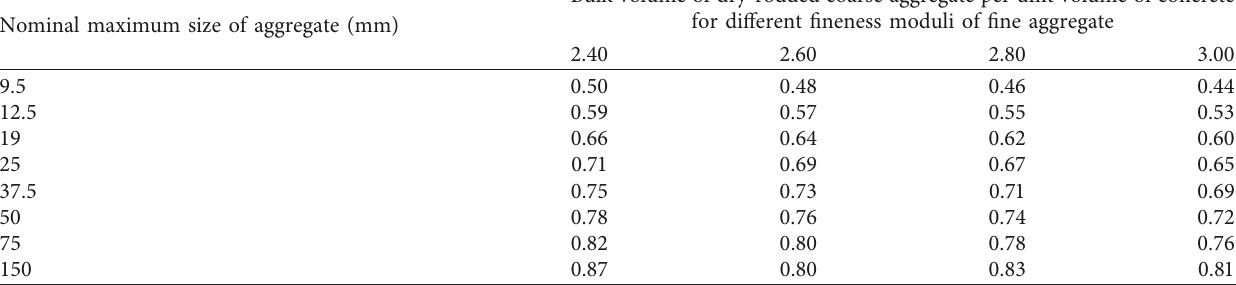
Table 4: Bulk volume of coarse aggregate per unit volume of concrete “Table 4 is reproduced from Kosmatka et al. [39] (under the creative commons attribution license/public domain).”